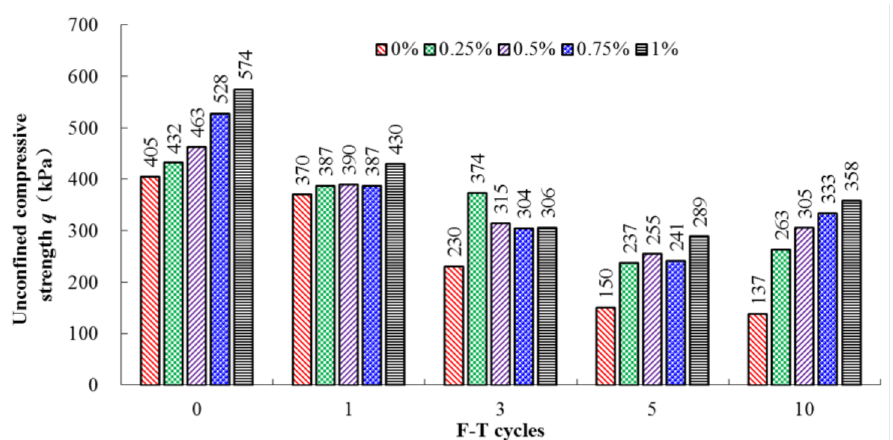
Figure 6. UCS of different fiber content after F–T cycles.